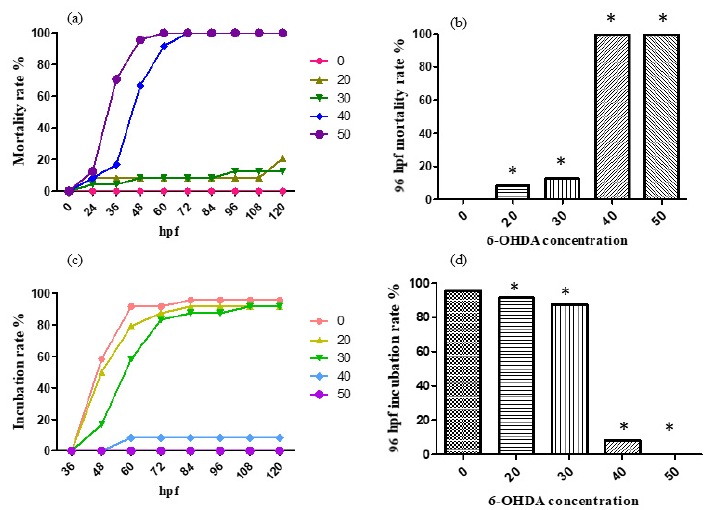
Figure 5. The mortality rate ( a , b )and incubation rate ( c , d ) after being 6-OHDA-treated (at a low concentration, 0–50 μ mol/L). * p <